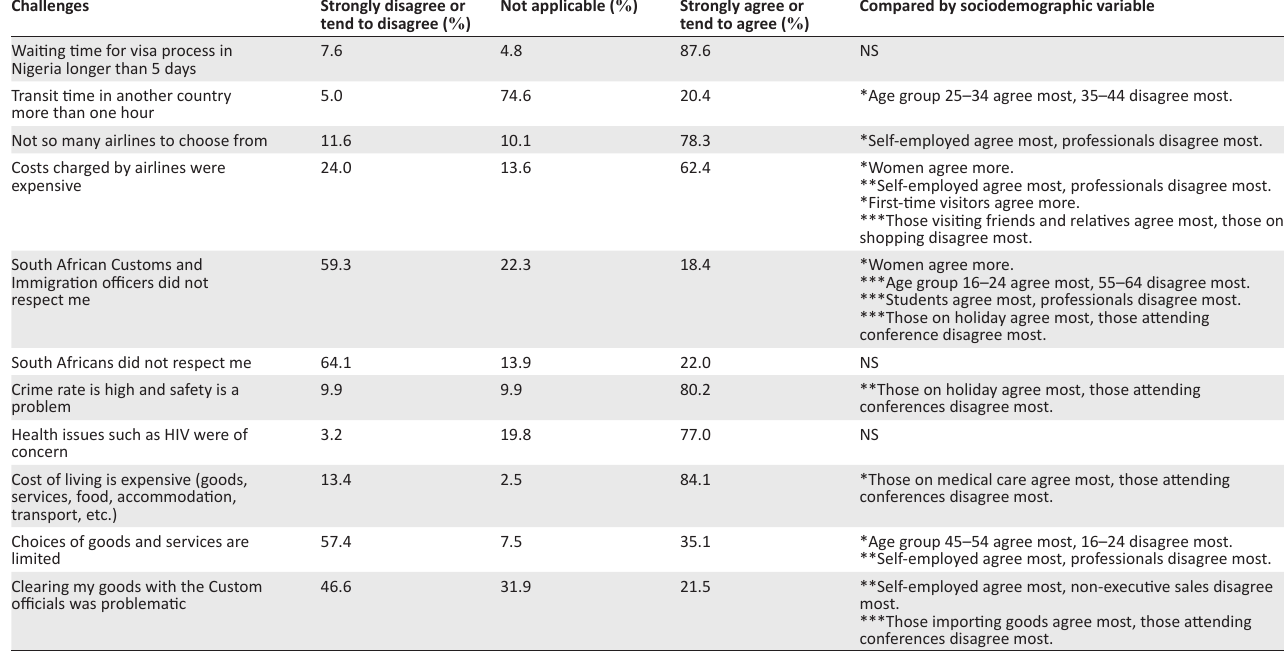
TABLE 5: Sociodemographic characteristics of the respondents versus visit challenges ( n = 313). Challenges Strongly disagree or Not applicable ( % ) Strongly agree or tend to disagree ( % ) tend to agree ( %